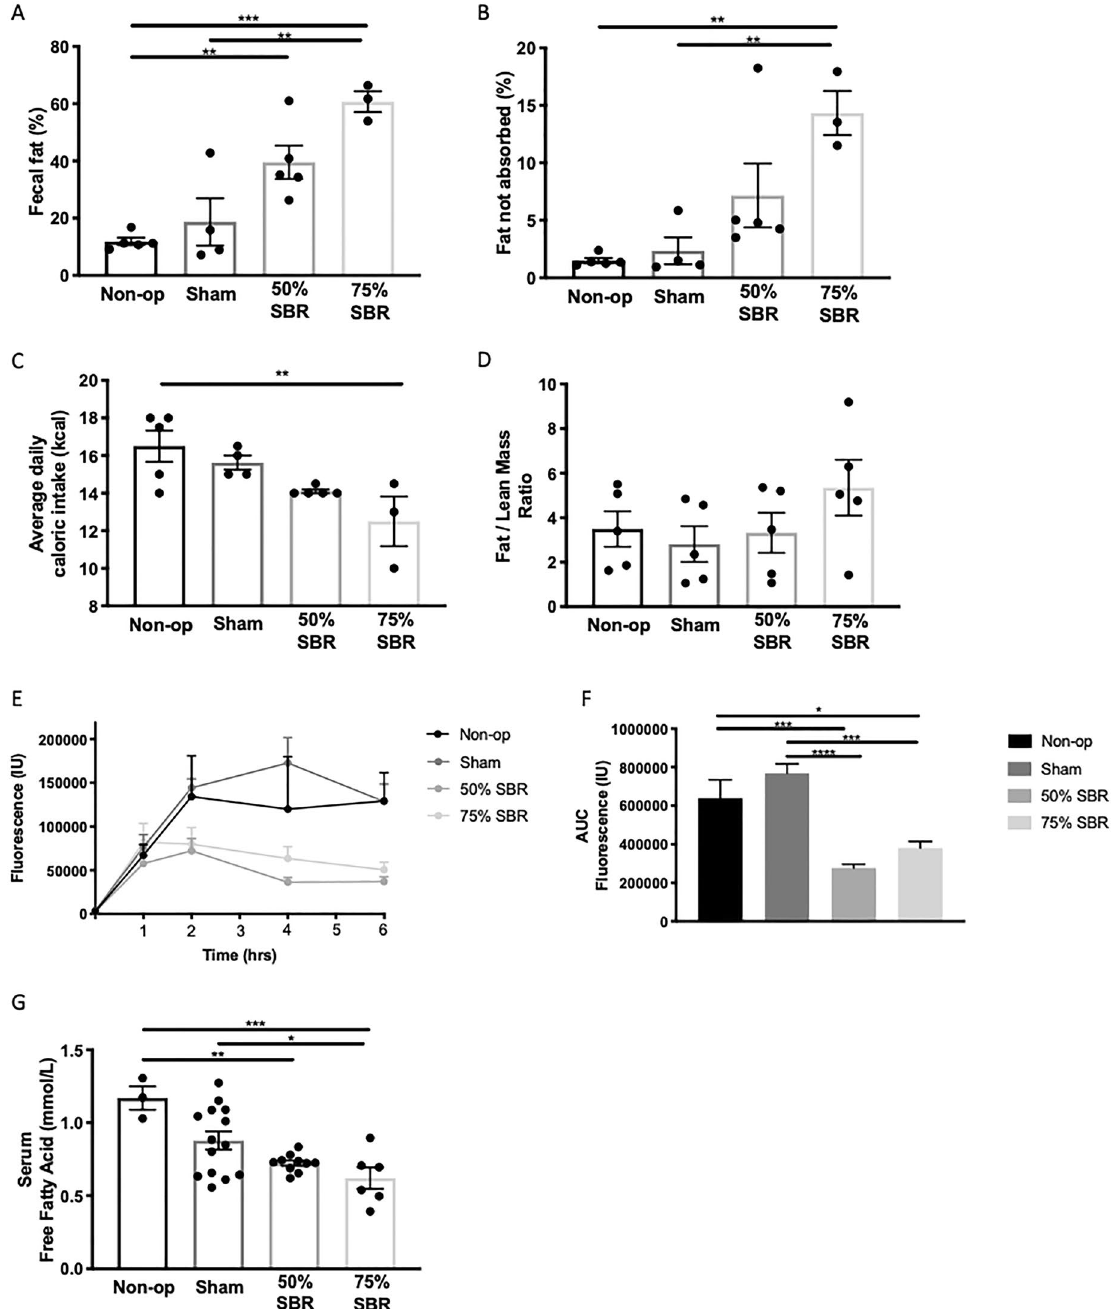
Figure 3. ( A ) Fecal fat, ( B ) % fat unabsorbed, and ( C ) average daily caloric intake over two days at approximately one year after resection in non-op ( n = 5), sham ( n = 4), 50% SBR ( n = 5), and 75% SBR ( n = 3) mice. ( D ) Fat to lean mass ratio at approximately one year after resection in non-op, sham, 50% SBR, and 75% SBR mice ( n = 5 for all groups). ( E ) Kinetic C16-Bodipy-labeled olive oil fluorescence and ( F ) area under the curve in non-op ( n = 5), sham ( n = 7), 50% SBR ( n = 6), and 75% SBR ( n = 5) mice. ( G ) Serum free fatty acid levels non-op ( n = 3), sham ( n = 14), 50% SBR ( n = 9), and 75% SBR ( n = 6) mice. * p < 0.05, ** p < 0.01, *** p <